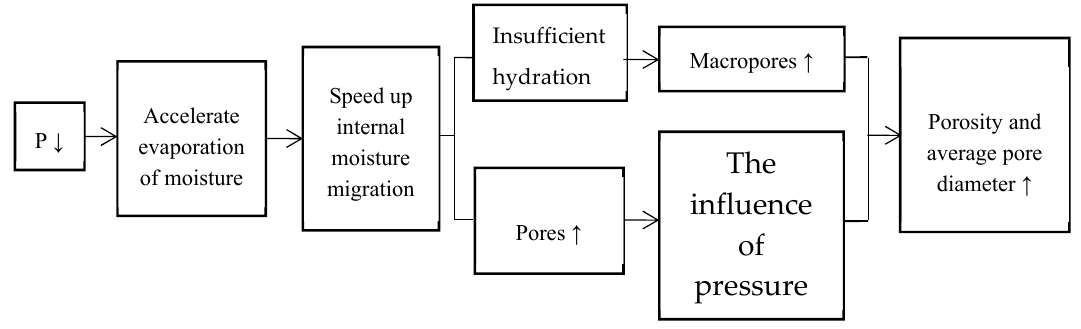
Figure 6. Schematic diagram of pore change.